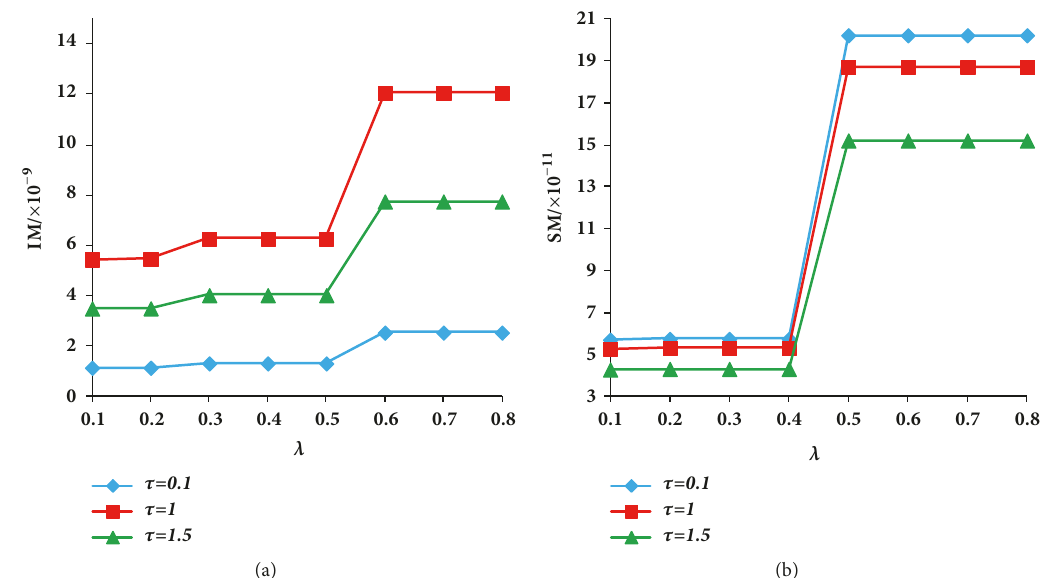
Figure 9: The trend of the change of metrics with 𝜆 increasing. Here, (a) IM of branch 513 and (b) SM of branch 2372.